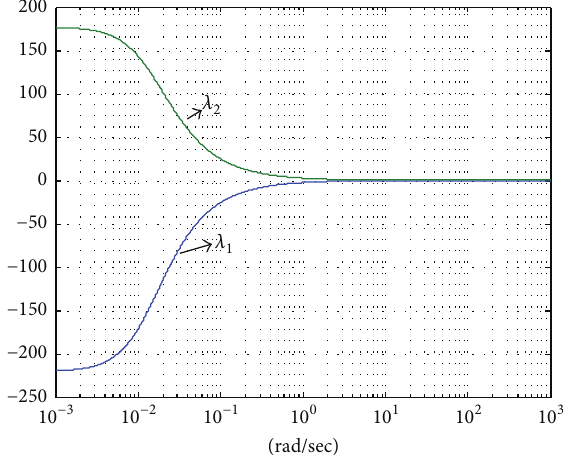
Figure 1: Eigenvalues of [𝐺(𝑗𝜔) + 𝐺 ∗ (𝑗𝜔)] (Case 1 ).